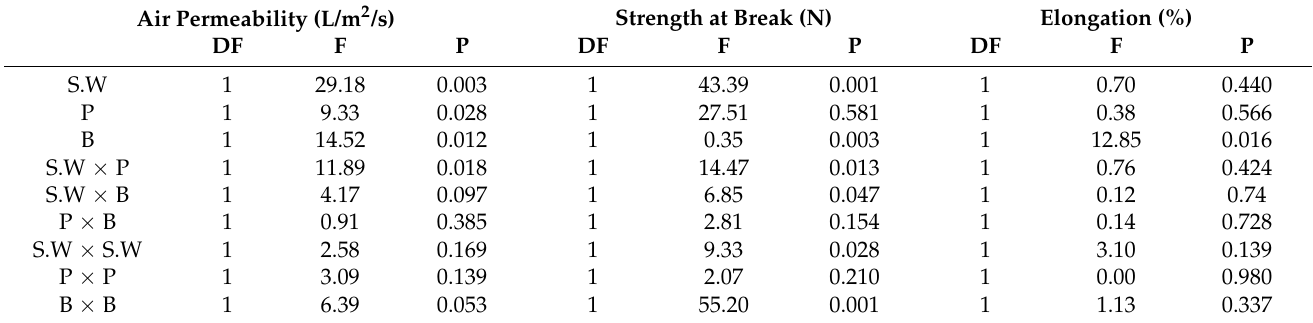
Table 5. Analysis of